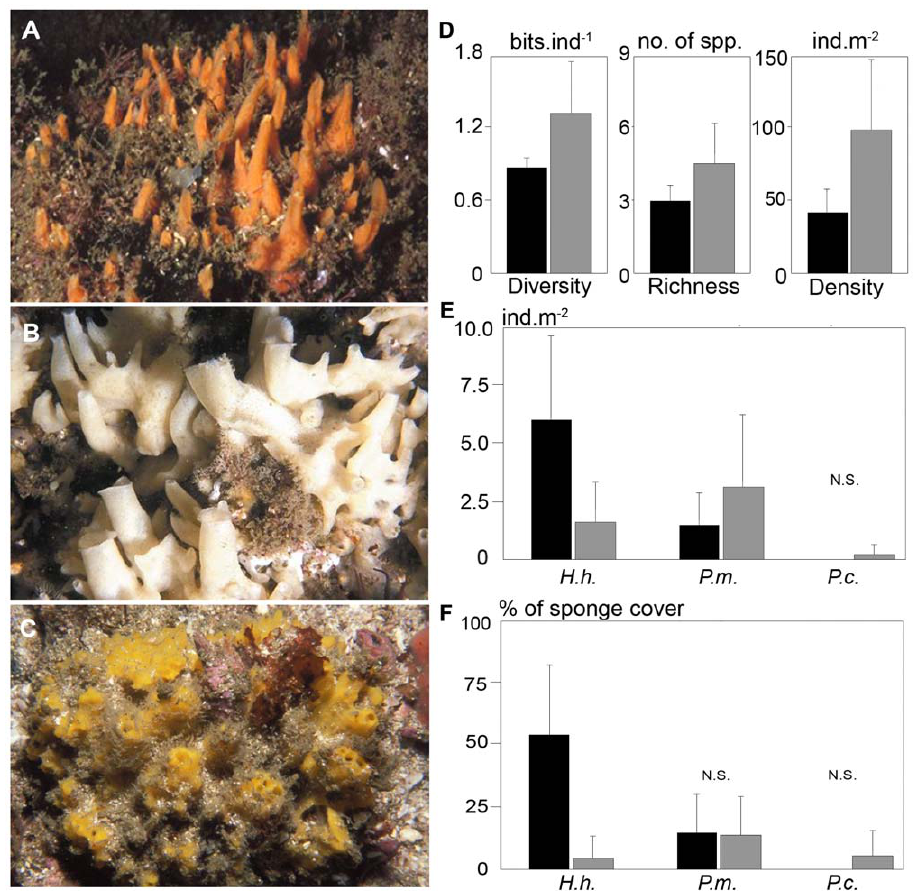
Figure 2. Sponge species, population and community structure. (A) Hymeniacidon heliophila (B) Paraleucilla magna (C) Petromica citrina (D) Indexes of whole sponge community structure: Shannon’s diversity H’ (bits per individual), species richness (number of species) and total sponge density (number of individuals per square meter) (E) Abundance of H. heliophila ( H.h .), P. magna ( P.m. ) and P. citrina ( P.c .) (number of individuals per square meter) (F) Dominance (% of total sponge cover) of H. heliophila, P. magna and P. citrina inside (black columns) and outside Guanabara Bay (gray columns). N.S., not significant. Error bars = standard deviation.